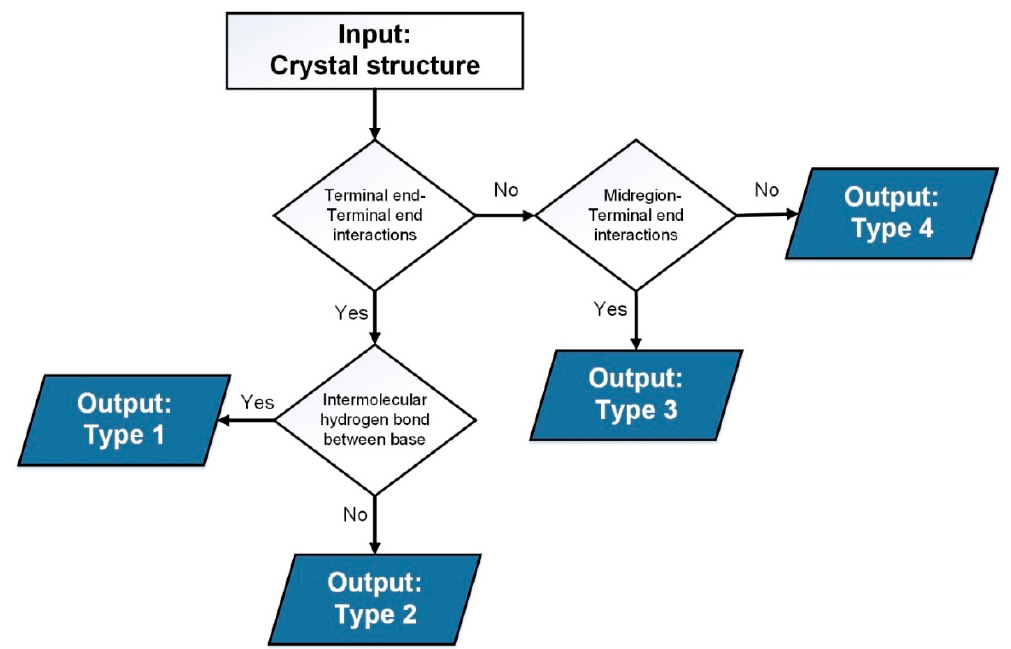
Figure 3. Logic flow for determining crystal packing type of DNA crystal structures. This flowchart 25